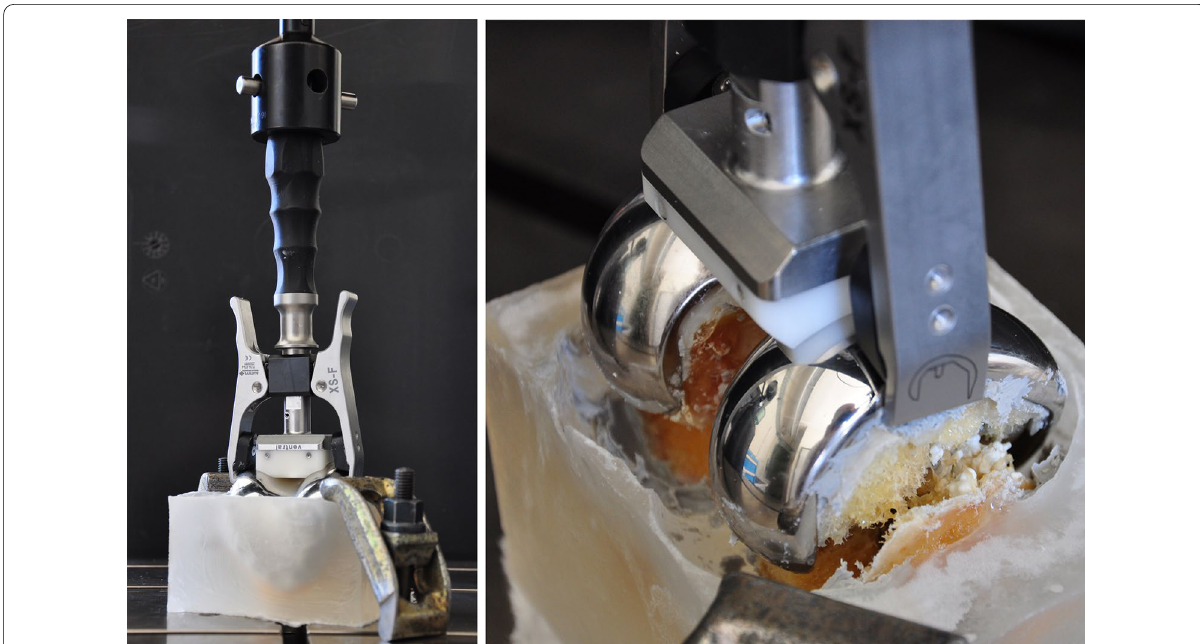
Fig. 5 Visualization of the setup with a specimen mounted for pull-out testing ( left ) and a detailed view of the femoral component clamping ( right )